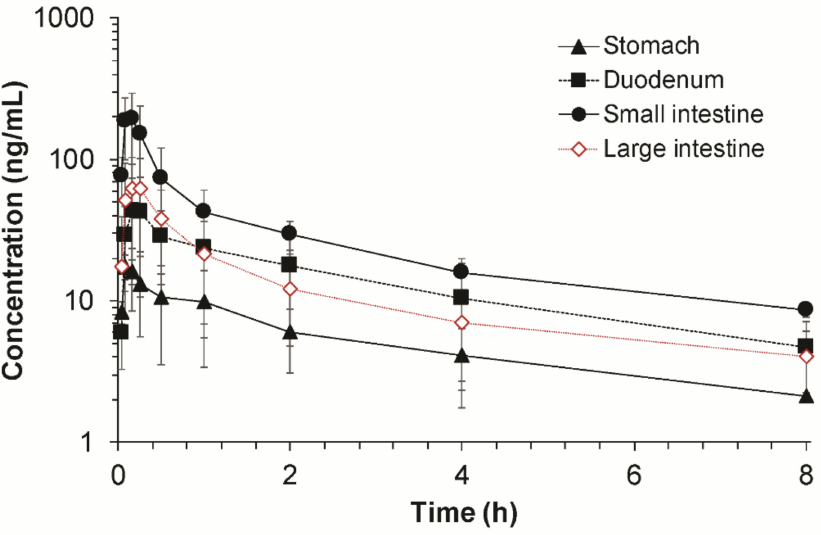
Figure 4. Plasma concentration–time profiles of fimasartan following administration of fimasartan (0.5 mg/kg) into each gastrointestinal segment in rats by the improved in situ absorption model ( n = 4–6, mean ± SD). Table 3. Noncompartmental pharmacokinetic parameters of fimasartan obtained after administration of fimasartan (0.5 mg/kg) into specific gastrointestinal segments in rats (mean ± SD). Stomach Parameter ( n = 4)